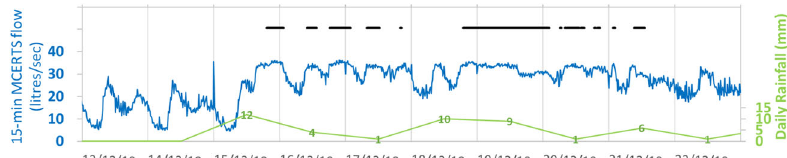
Fig. 1 WWTP1: example ef fl uent fl ow pattern for 10 days annotated with EDM con fi rmed spilling intervals. A 24-h (midnight to midnight) daily fl ow pattern of 96 15-min-interval average fl ow rates (litres/second) of treated ef fl uent is shown in blue. The black horizontal, linear annotations represent EDM recorded intervals denoting a discharge from a storm tank (i.e., consented spill or potentially unconsented spill of untreated sewage), the shortest being 15 min and the longest over 24-h. Total daily rainfall (mm/d) is provided in green. The fi rst two days, with no detected spills, show diurnal patterns of low fl ow between midnight (previous day) and the fi rst peak after mid-morning, followed by a lull until a second, smaller peak in the evening. The next seven days (15/12/18 through 21/12/18) involve spill intervals of various length (black EDM line), showing a fl attening of fl ow, which is typical of storm discharge during heavy rainfall. The last day shows elevated fl ows and a partial return to a diurnal fl ow pattern with no spills reported.